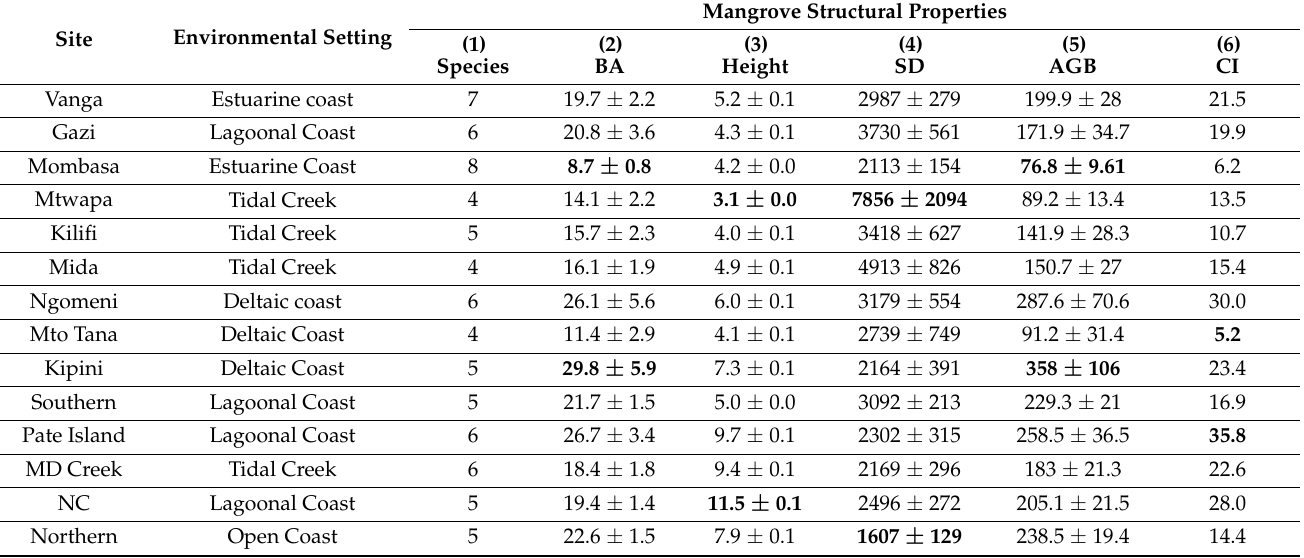
Table 4. Summary attribute table describing the environmental settings, forcing functions and structural properties of mangroves along the Kenyan coast. (1) denotes the number of species encountered in each site, (2) is basal area (BA) (m 2 ha − 1 ), (3) is canopy height (m), (4) is stand density (SD) (trees ha − 1 ), (5) is standing/aboveground biomass (AGB) (Mg ha − 1 ), (6) is complexity index (CI). Basal area, canopy height, stand density and standing biomass are reported as mean ± standard error. Southern is Southern swamps, MD Creek is Mongoni Dodori Creek, NC is Northern Central swamps, Northern is Northern